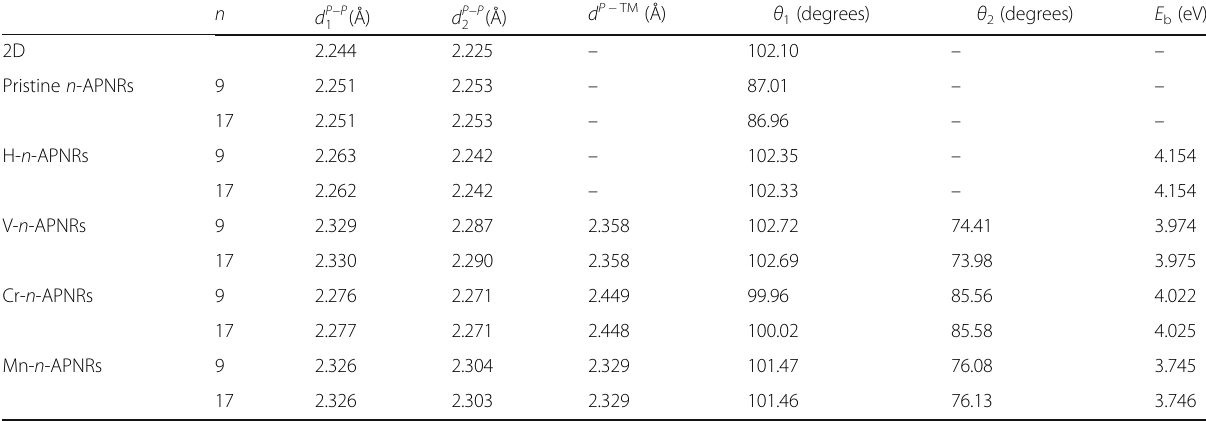
Table 1 The geometry parameters and the binding energy of pristine and modified n -APNRs for n = 9 and 17 are listed with those of 2D structure. The FM configuration is assumed for TM-modified APNRs